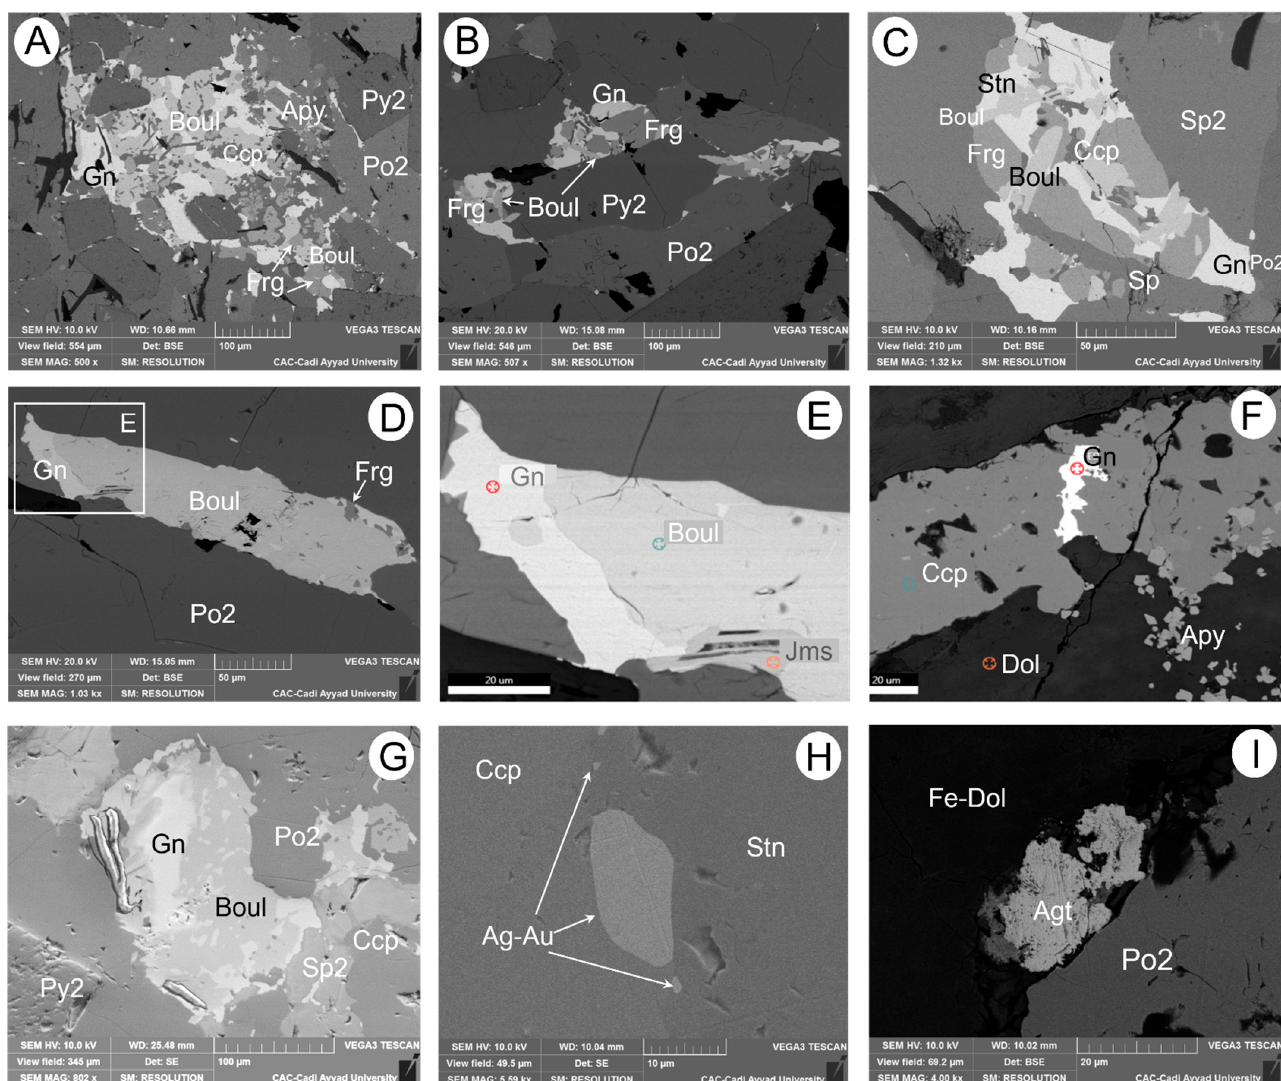
Figure 6. Ore minerals from Koudiat Aïcha observed by scanning electron microscopy. ( A , B , C ): Sulfides from ore stage II (pyrite 2, pyrrhotite 2, arsenopyrite 2) overgrown by sulfides from stage III (chalcopyrite, galena, boulangerite, Ag-tetrahedrite-freibergite). ( D , E ): Late assemblage (galena, boulangerite, Ag-tetrahedrite-freibergite, jamesonite) overgrowing pyrrhotite 2. ( E ): Detail of ( D , F ): Dolomite crosscut by veinlet of chalcopyrite itself crosscut by galena. ( G ): Myrmekitic texture of galena–boulangerite. ( H , I ): Ag minerals: Ag-Au alloy in a fissure bordering chalcopyrite and stannite ( H ) and argentite in late Fe-dolomite vein crosscutting pyrrhotite 2. Po: pyrrhotite, Sp: sphalerite, Py: pyrite, Asp: arsenopyrite, Ccp: chalcopyrite, Stn: stannite, Gn: galena, Boul: boulangerite, Frg: Ag-tetrahedrite/freibergite, Jms: Jamesonite, Ag-Au: Ag-Au alloy, Agt: argentite, Fe-dol: later ferroan dolomite.